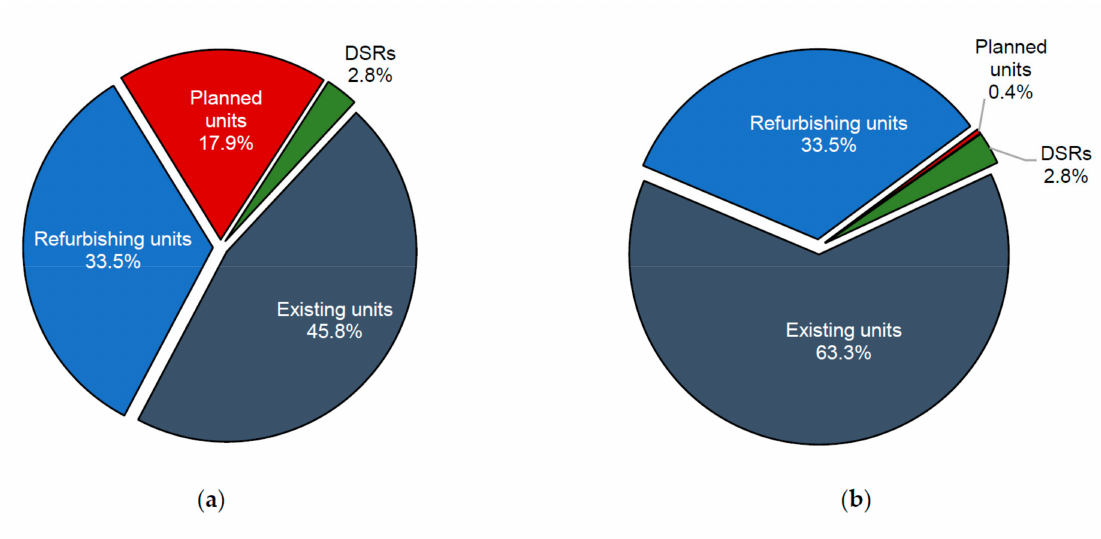
Figure 5. Structure of capacity obligation volumes contracted in main capacity auction for 2021 delivery year–break down by capacity market units: ( a ) official (declared) assignment; ( b ) actual status of capacity market units. Source: Own analysis based on